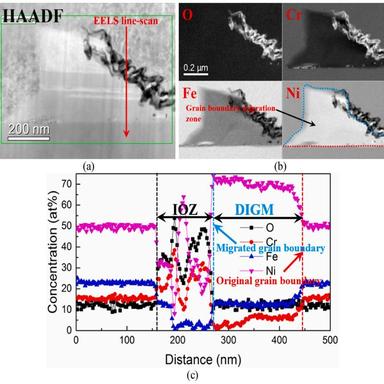
(a) HAADF image showing the morphology around a representative crack tip prepared from Fe-16Cr-60Ni alloy tested at 360 ◦C; (b) EELS elemental O K edge and Cr/Fe/Ni L edge maps; (c) EELS quantitative composition line profiles across the IOZ and DIGM zone.